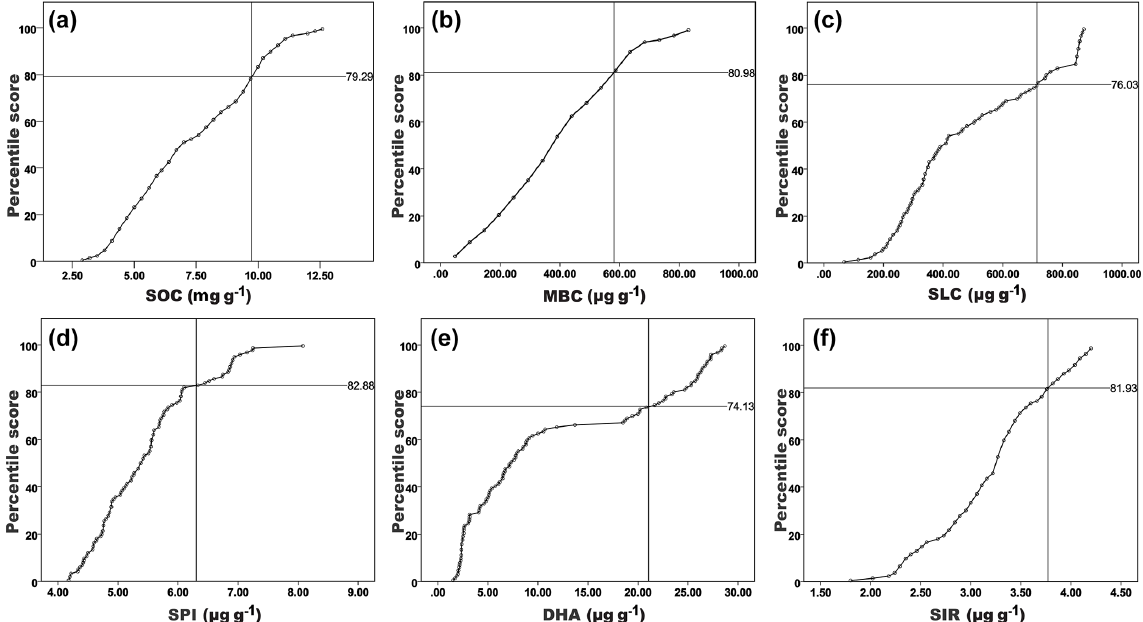
Figure 2. Cumulative normal distribution for scoring the observed soil biological variables in four different nutrient management plots of three different agroclimatic zones of Tamil Nadu, India. A – soil organic carbon; B – microbial biomass carbon; C – soil labile carbon; D – soil protein index; E – dehydrogenase activity; F – substrate-induced respiration. In the distribution curve, the mean + SD of measured values was intercepted and the scoring percentile for each variable was calculated and presented in the corresponding plot.